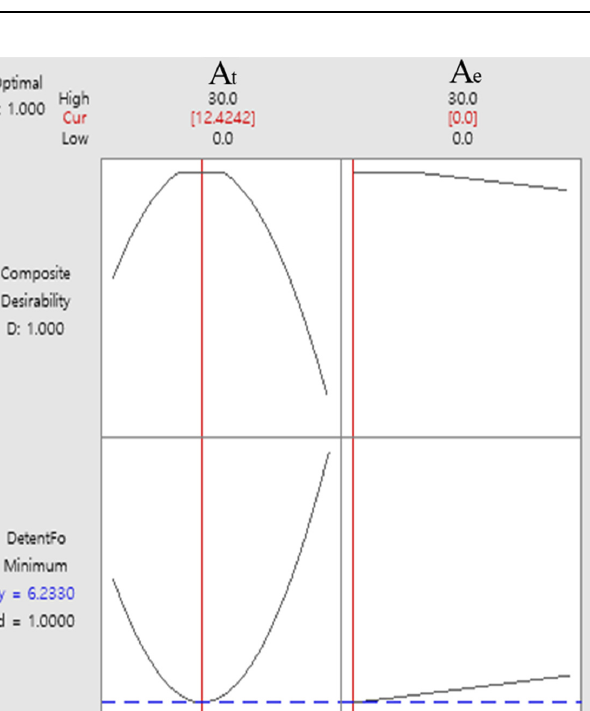
Figure 18. Optimization of detent force using response surface methodology.